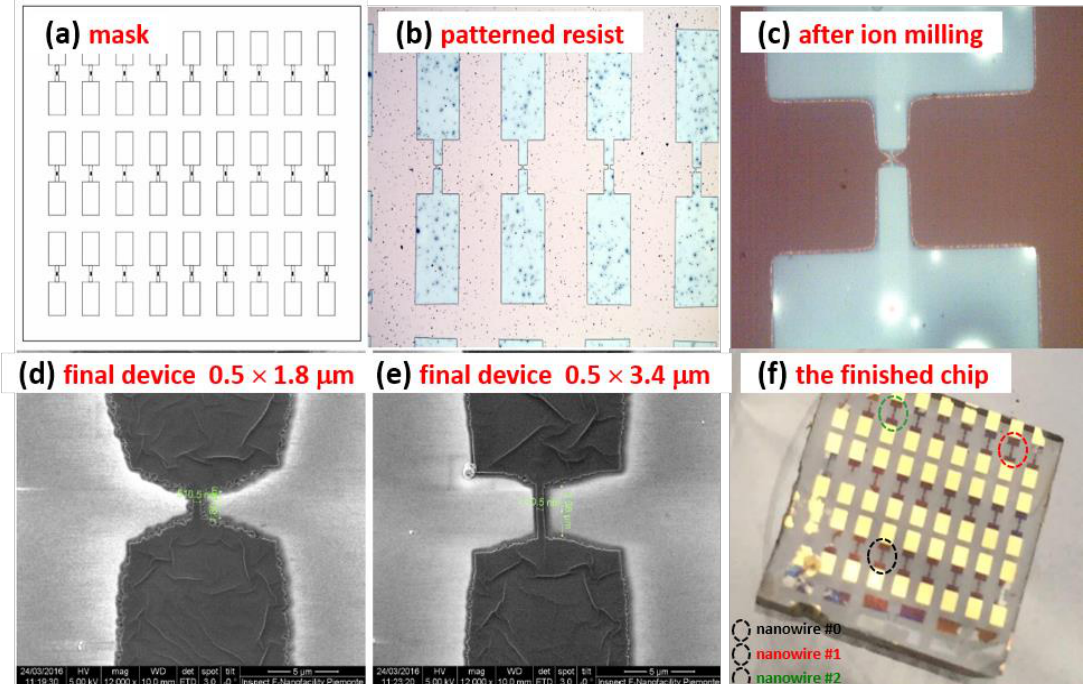
Figure 1. Microphotographs and images representing the different steps of the nanowires fabrication process: from the used mask design ( a ) to the finished 1 cm 2 chip, after electronic and optical lithography ( b – f ). The devices, whose experimental results are here reported and discussed, are evidenced with colorized circles.